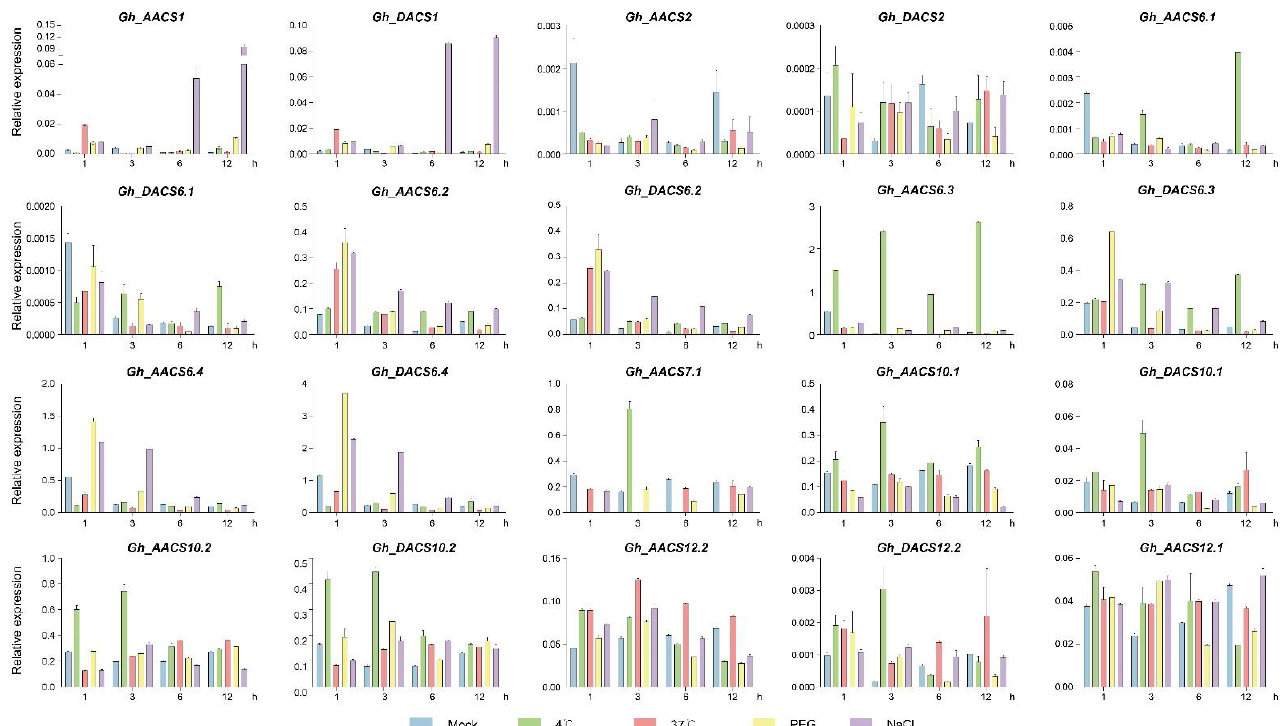
Figure 9. Expression levels of GhACS genes under cold, heat, drought, and salt stresses at different times by quantitative PCR analysis.